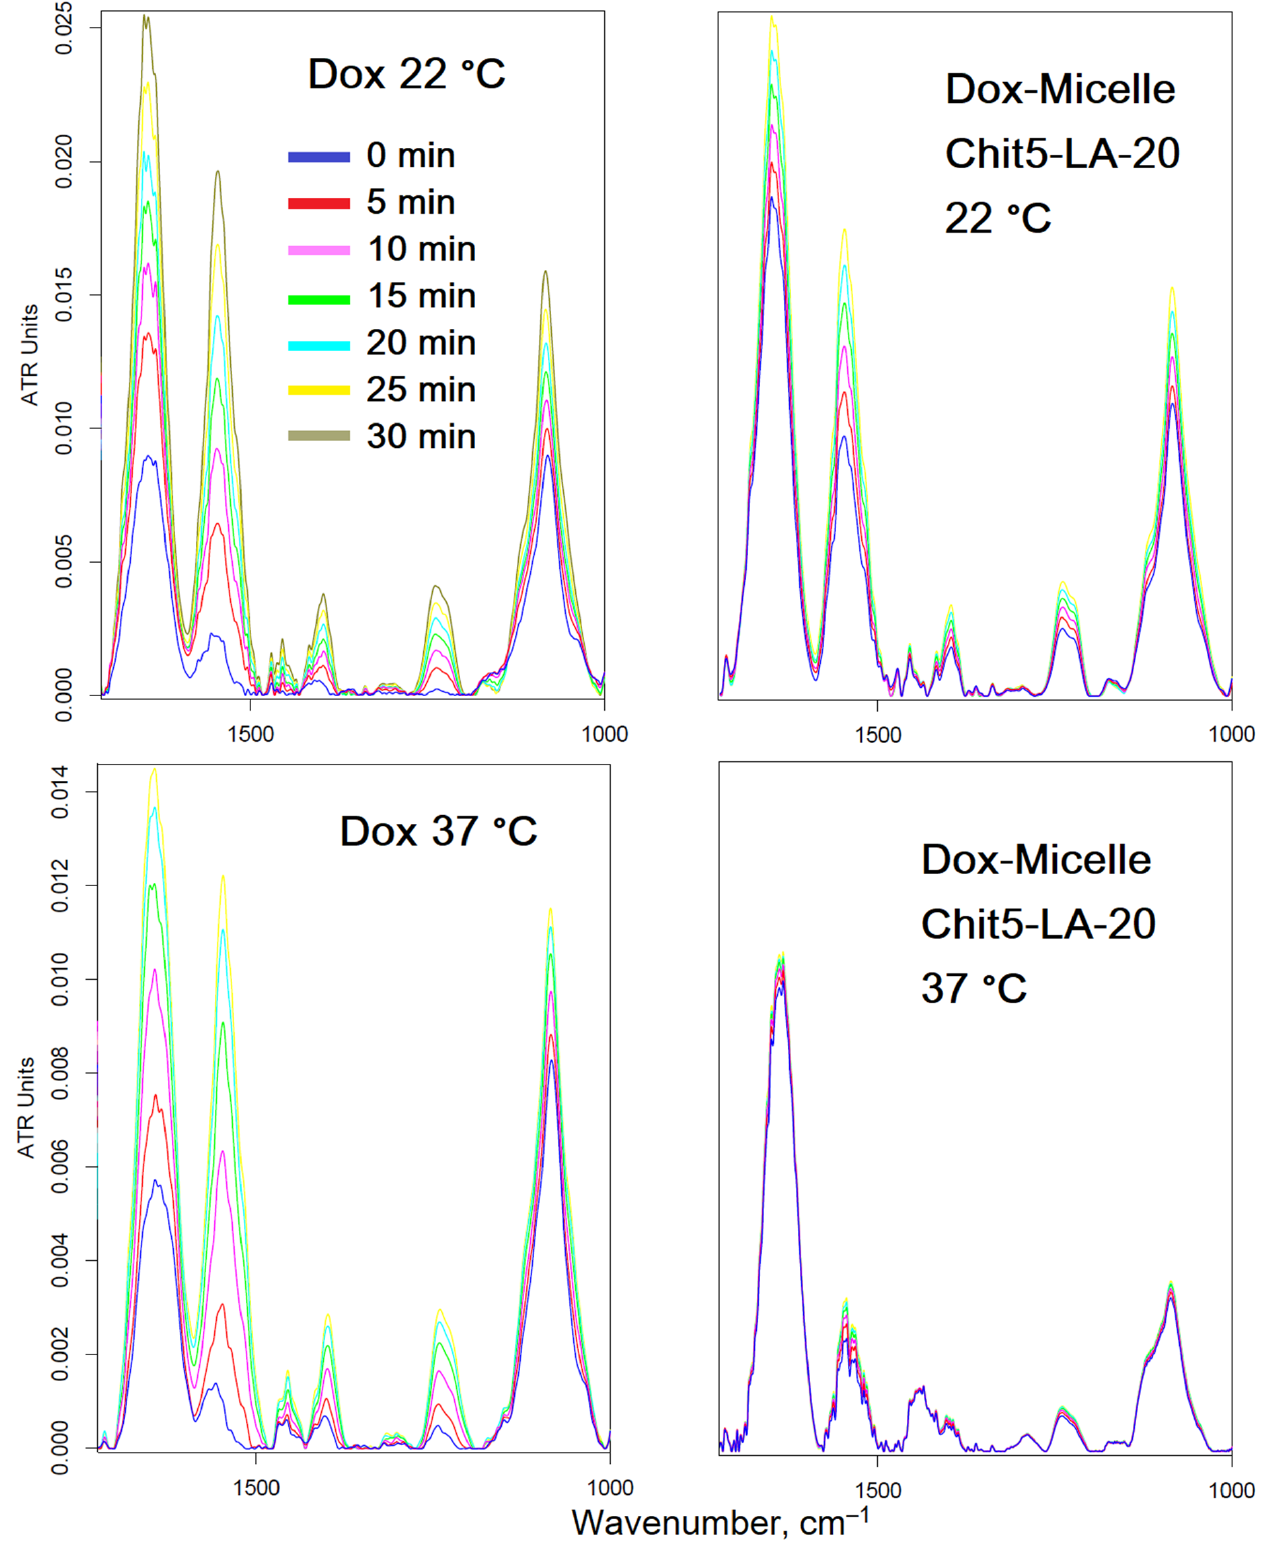
Figure 9. FTIR spectra of healthy HEK293T cells during incubation for 30 min with doxorubicin (0.1 mg/mL) in free form or in micellar form (polymer:Dox = 1:2 w / w ). pH = 7.4 (PBS, 0.01 M). T = 22 or 37 °C.